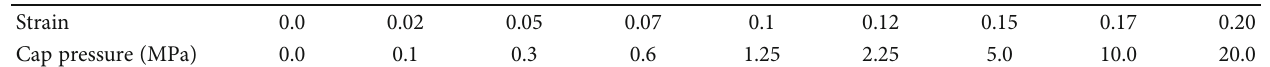
Table 3: Mechanical parameters of the double-yield gob elements.